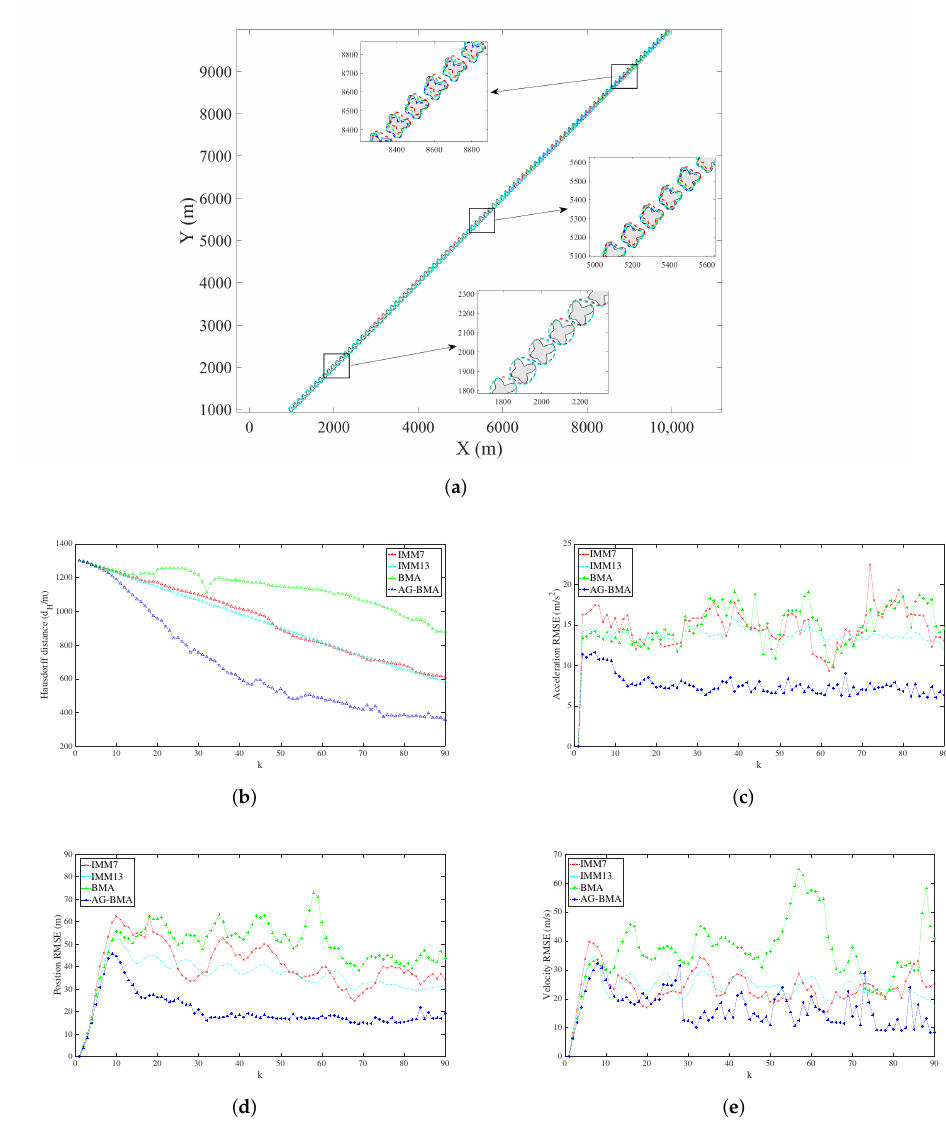
Figure 8. Performance comparison of the four algorithms. ( a ) Trajectory of the target ( b ) Hausdorff distance. ( c ) RMSE of acceleration. ( d ) RMSE of position. ( e ) RMSE of